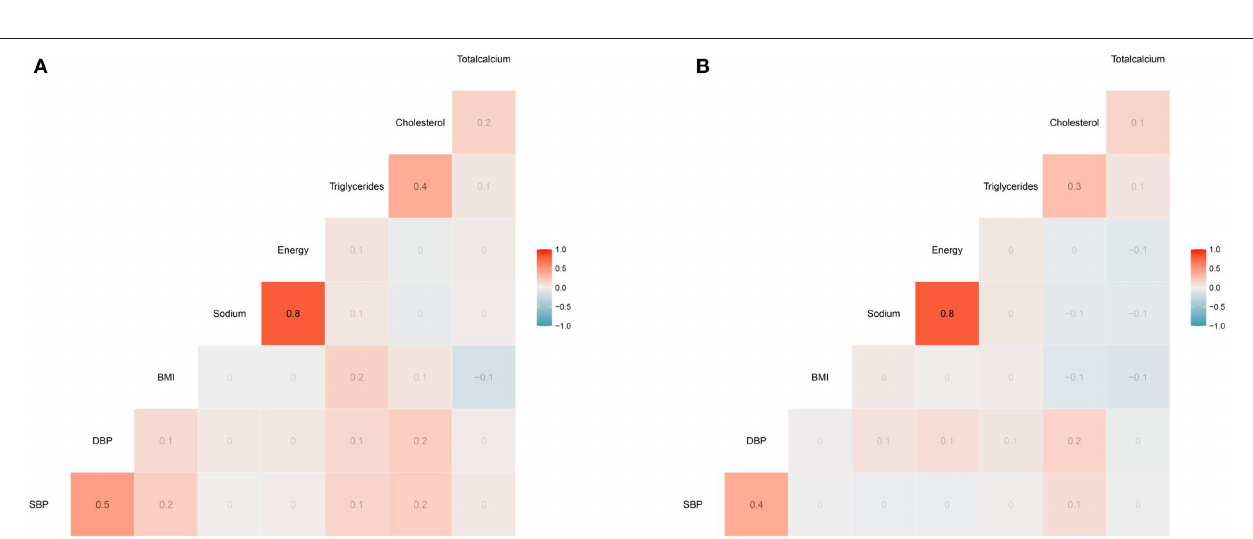
FIGURE 1 | Restricted cubic spline of the association between serum total calcium and hypertension. The association was adjusted for age, gender, race/ethnicity, education levels, BMI, diabetes history, smoking status, alcohol consumption, sodium intake, triglycerides, total cholesterol levels, albumin, eGFR, and serum phosphorus. The median total calcium (9.4 mg/dl) was chosen as a reference. The plot showed a reduction of the risk within the lower range of serum calcium, which reached the lowest risk around 9.1 mg/dl and then increased thereafter. OR, odds ratio; CI, confidence intervals.